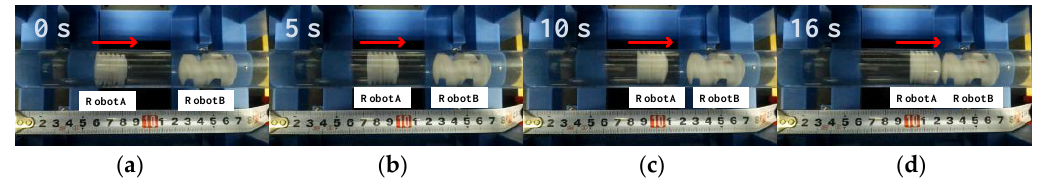
Figure 11. The video snapshots of the docking procedure: ( a ) Robot A is away from Robot B; ( b ) Robot